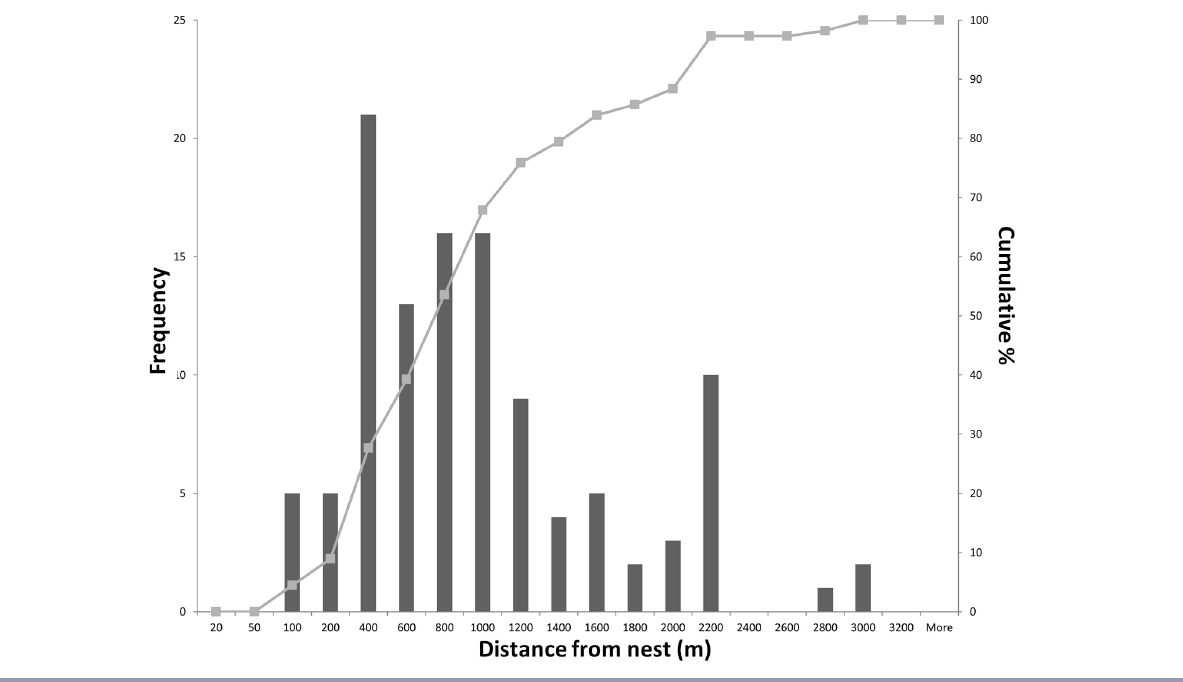
Fig. 2 . Distance of capture sites to the nest. The boxed line represents the cumulative percentage of captures at each distance bin.